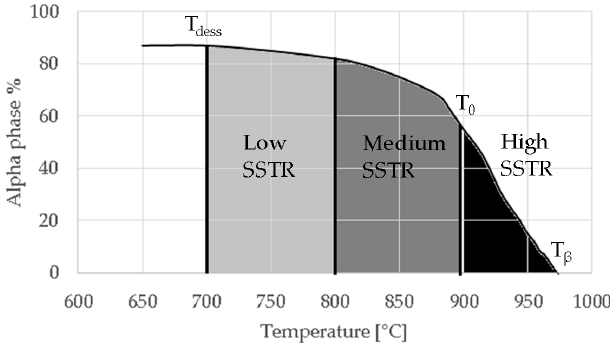
Figure 3. Schematic of temperature regions and key temperatures in the SSTR vs estimated α phase fraction.